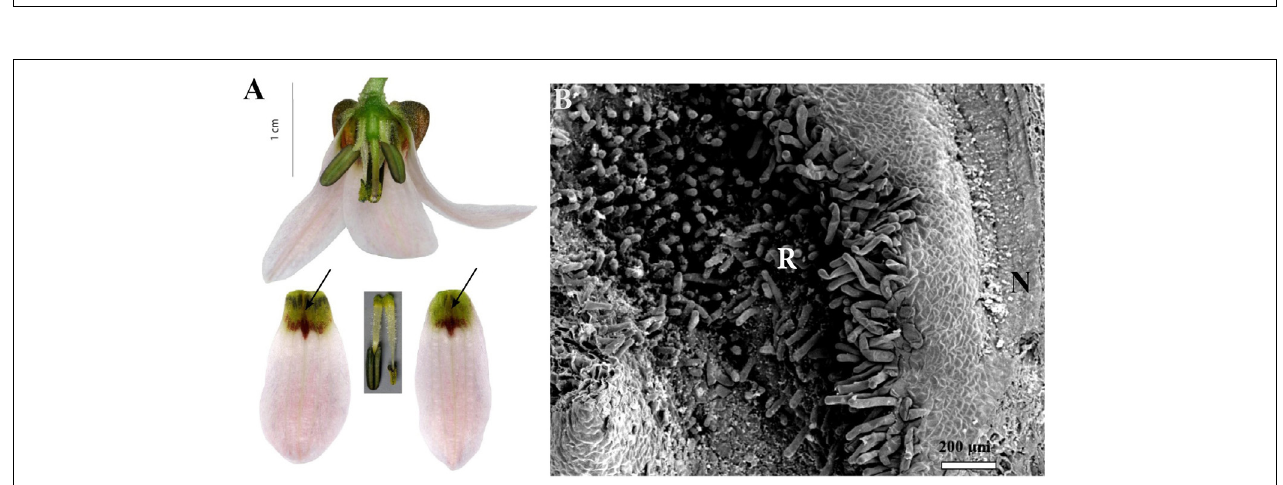
FIGURE 10 | Flowers and nectaries of F. raddeana . Macro and SEM images. (A) Flowers and tepals, nectaries marked with arrows. (B) Part of outer tepal showing depressed, cup-shaped nectary (N), and slightly convex cells of surrounding area.